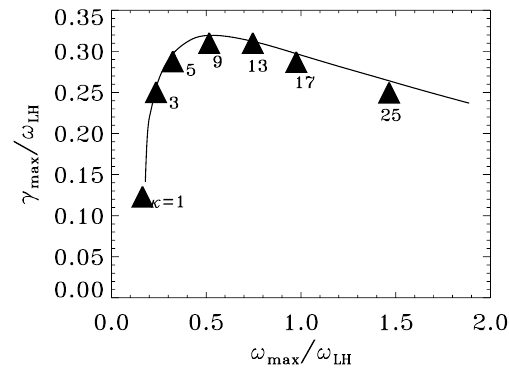
Fig. 4. Relationship between the maximum linear growth rate and the corresponding real frequencies for different k values (Dob´e et al.,